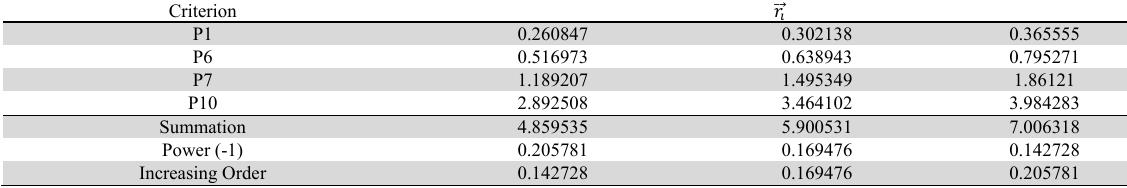
Process of deriving fuzzy weights Criterion